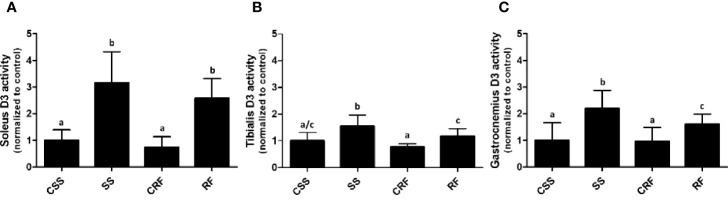
D3 activity in soleus (A), tibialis anterior (B), and gastrocnemius (C) muscles. CSS, control of semi-starved rats; SS, semi-starved rats; CRF, control of refed rats; RF, refed rats. In soleus, D3 activity ranged from 0.01 to 0.08 fmol/min/mg. In tibialis anterior, it ranged from 0.005 to 0.020 fmol/min/mg. In gastrocnemius, it ranged from 0.0013 to 0.01 fmol/min/mg. Data were normalized to the value obtained for CSS animals (set as 1). (A, C: n=6-10; B: n=5-8). Results are shown as mean values ± SD. Multiple comparisons between the groups were statistically evaluated by 1-way ANOVA followed by the Newman–Keuls test. Bars labeled with dissimilar letters are significantly different; in (A), SS vs. CSS, SS vs. CRF, RF vs. CRF, and RF vs. CSS, p<0.001; in (B), SS vs. CSS, p<0.01; SS vs. CRF, p<0.001, SS vs. RF, and RF vs. CRF, p<0.05; in (C), SS vs. CSS and SS vs. CRF, p<0.001; SS vs. RF and RF vs CSS, p<0.05.